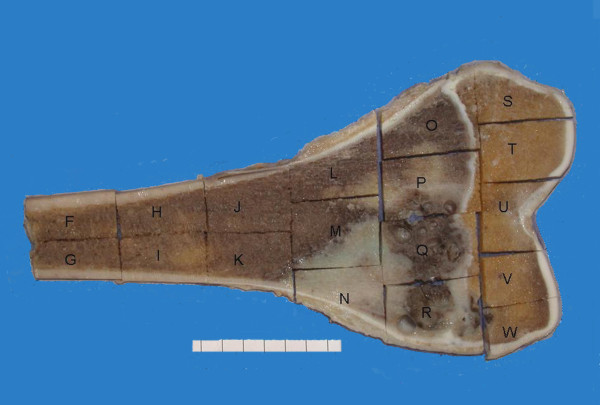
Photograph of a slab taken through a specimen of an osteosarcoma of the lower femur. This provides information on the nature and site of sampled tissue blocks, the location of the tumour, its relation to bone resection margins, and permits calculation of the extent of tumour necrosis.